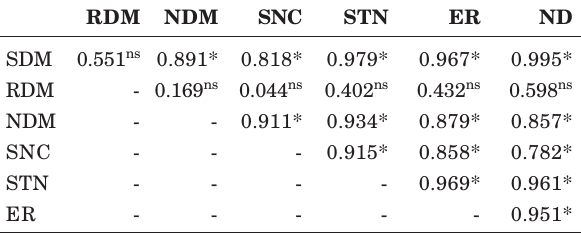
ns and *: not significant and significant at 5 % probability, respectively, according to t